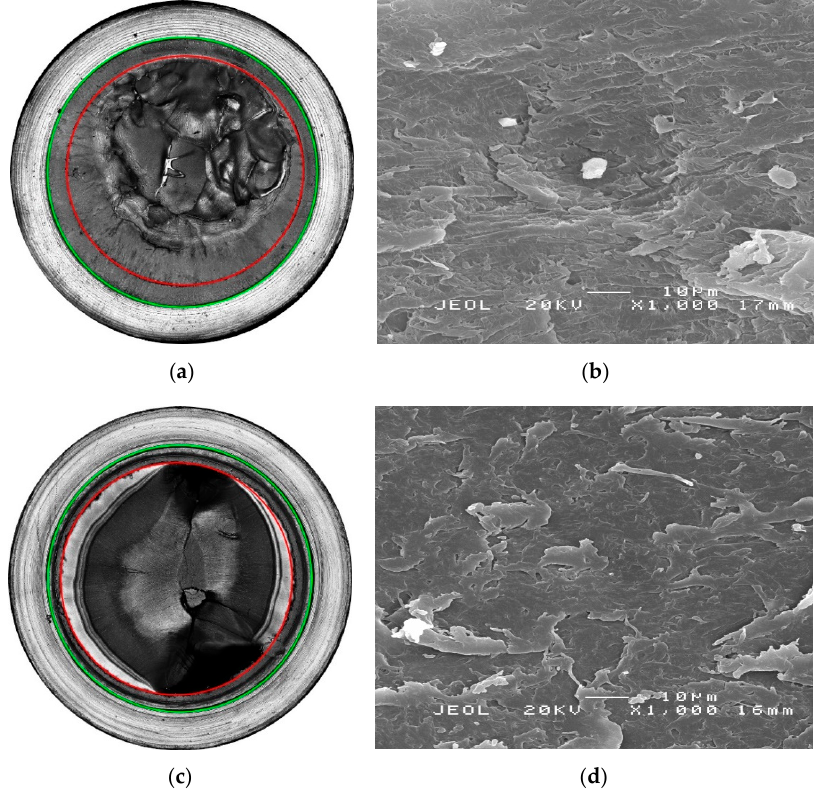
Figure 9. Fracture surface with emphasized end of stable crack growth (red circle) together with a detail of the stable crack growth region for ( a , b ) PP-R α and ( c , d ) PP-R β tested at 60 °C in chlorinated water with 5 mg/L free chlorine.